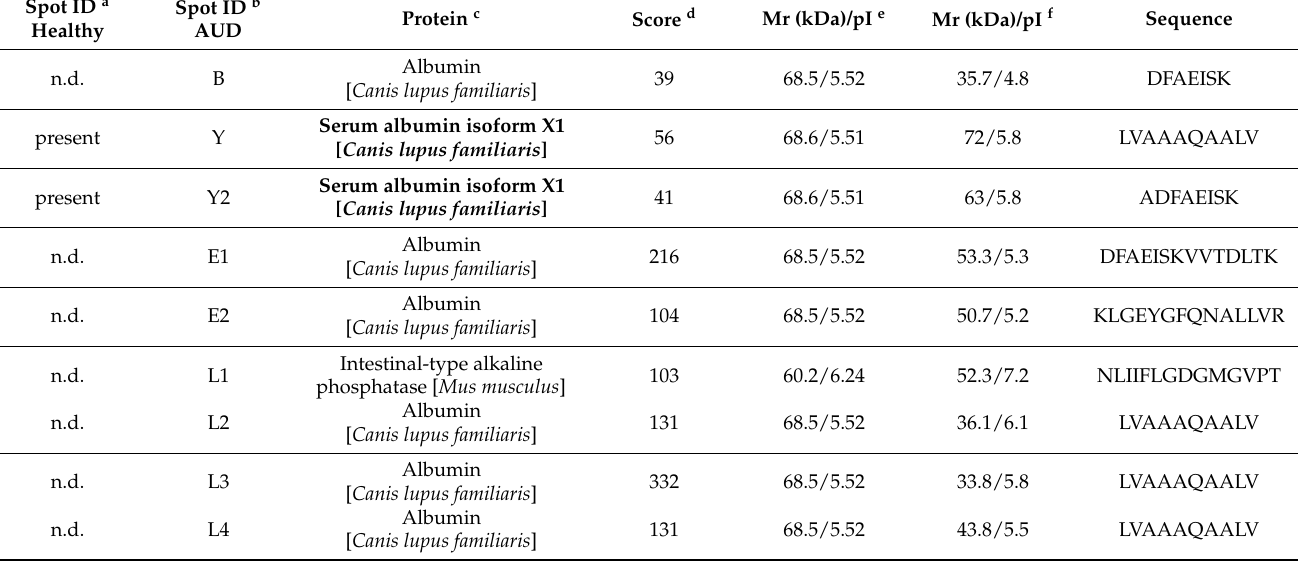
Figure 2. Quantitative analysis of each spot in the feces of dogs affected by acute uncomplicated diarrhea at T0, T1, and T2 determined by the PDquest software. Each spot was identified as